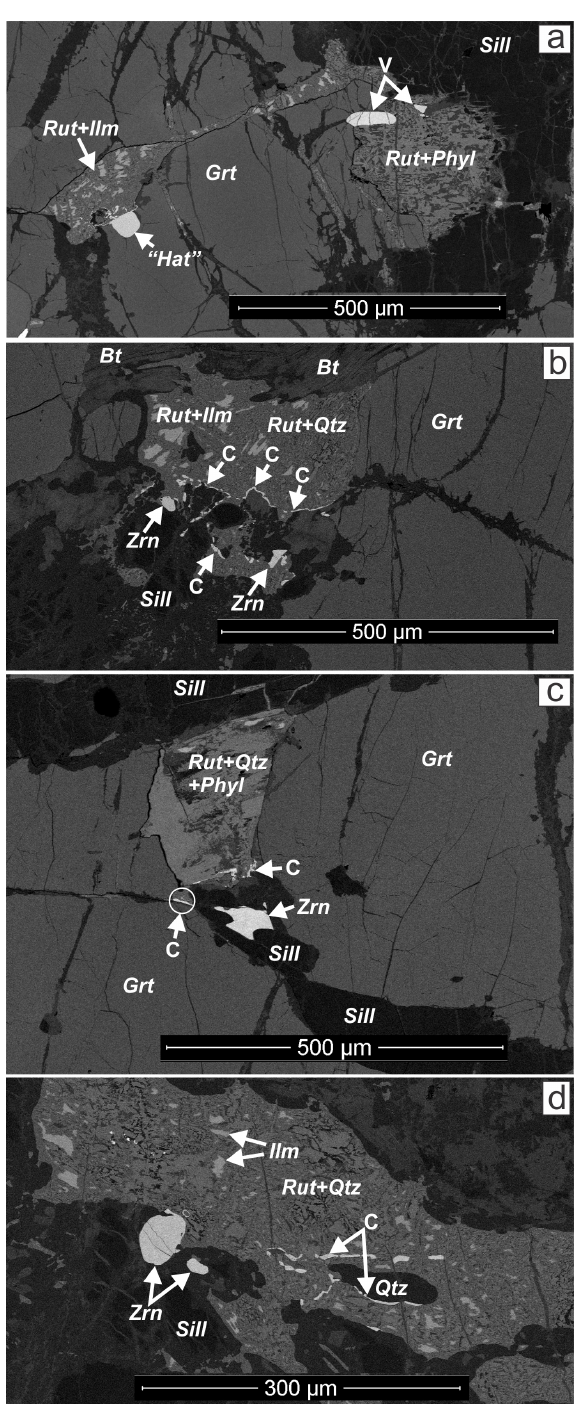
Figure 5. BSE images of mineral reactions that contain detrital zir- con grains and associated zircon coronae. Mineral abbreviations are as in Fig. 1: Bt: biotite; Hat: hat-shaped zircon aggregate. “V” high- lights the vermicular zircon grains, “C” points to the zircon coronae, and Zrn is the preexisting detrital and metamorphic zircon grains. Arrows in panel (b) show the direction of the mineral reaction